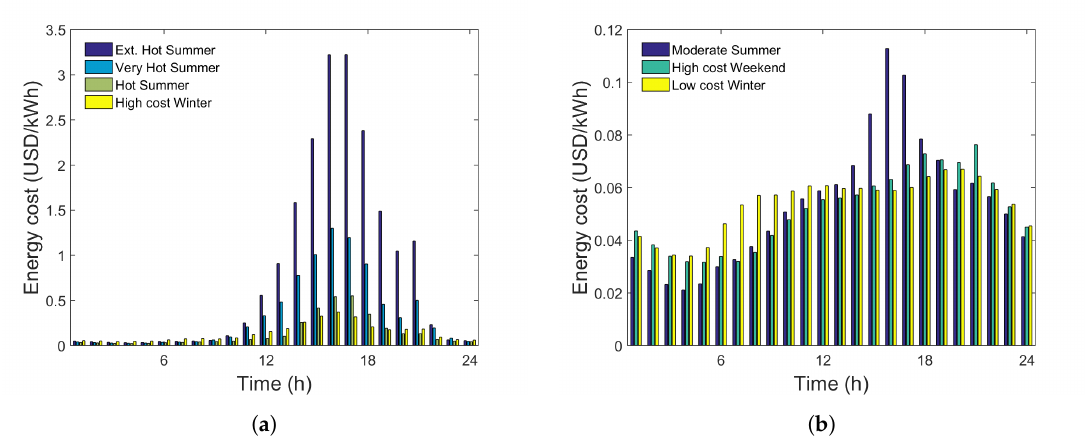
Figure 3. Example of “complex” tariff with different day types and hourly changes. ( a ) Days presenting a large price variation. ( b ) Days presenting a moderate variation.